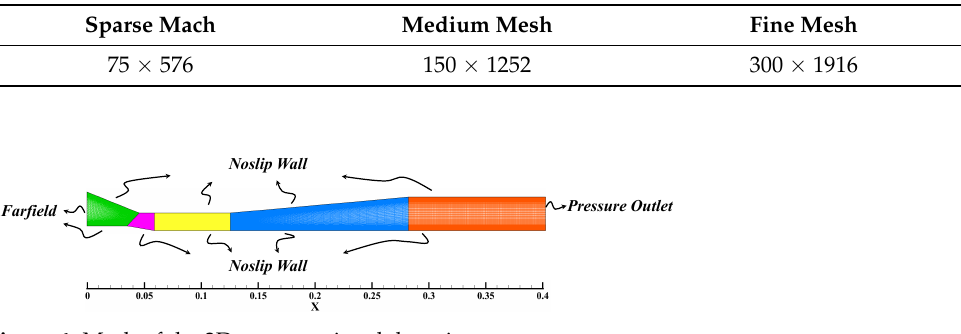
Table 1. Three sets of meshes with different sparsities.